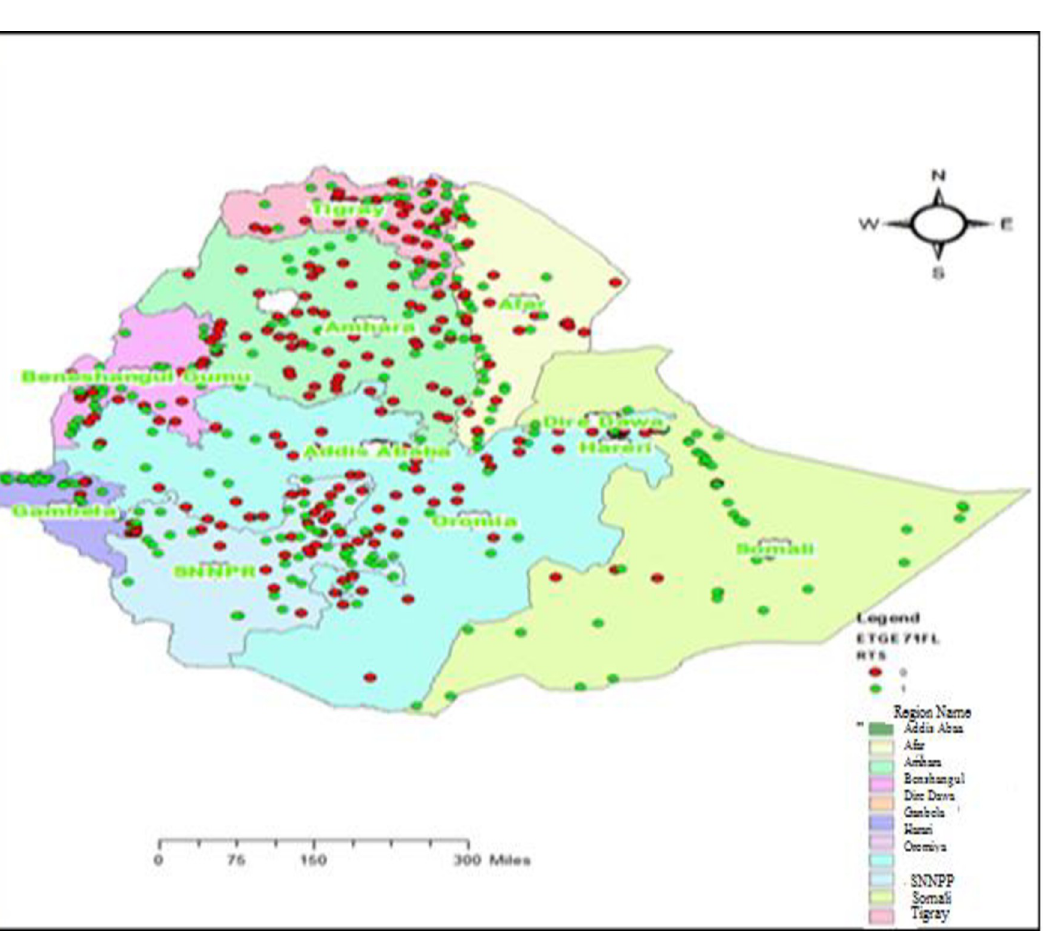
Fig 1. Spatial distribution of malaria test in Ethiopia, from EMIS